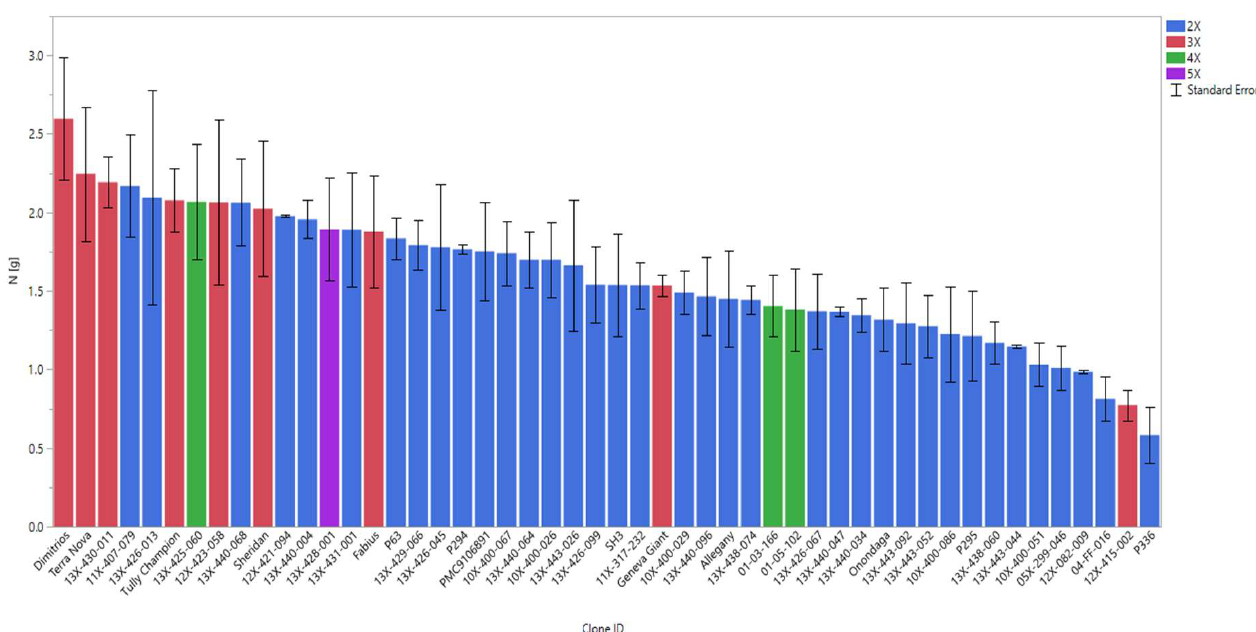
Figure 7. Mean values (± standard error) of nitrogen uptake (g) of shrub willow genotypes in the fertilizer treatment group shaded according to their ploidy; diploid_2X (blue), triploid_3X (red), tetraploid_4X (green), and pentaploid_5X (purple).